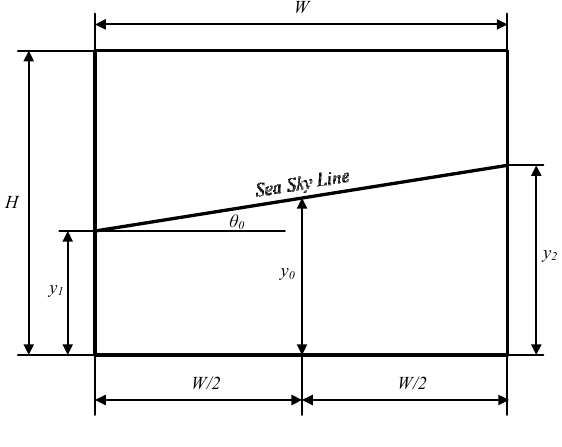
Figure 9. Geometric model of SSL detection.